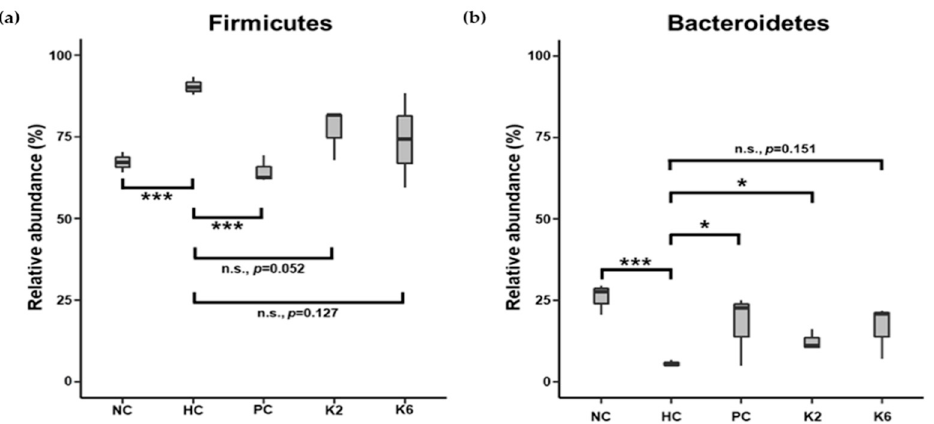
Figure 8. Fecal microbial diversity in each group. ( a ) Principal coordinates analysis (PCoA) plot using weighted UniFrac distance matrix; ( b ) Bar plot of relative bacterial phylum abundance. Each bar represents results of three pooled fecal samples. NC, normal diet control; HC, HF/HF diet control; PC, HF/HF diet with silymarin; K2, HF/HF diet with ATG-K2; K6, HF/HF diet with ATG-K6.